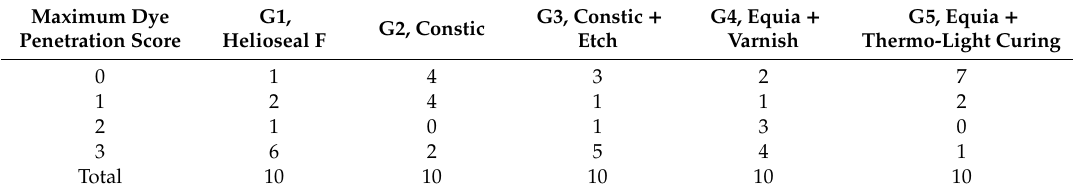
Table 1. Frequency table of the worst score per sealant (0-no evidence of dye penetration; 1-dye penetration to less than one third from the margin; 2-dye penetration up to two thirds from the margin; 3-dye penetration up to bottom of fissure).